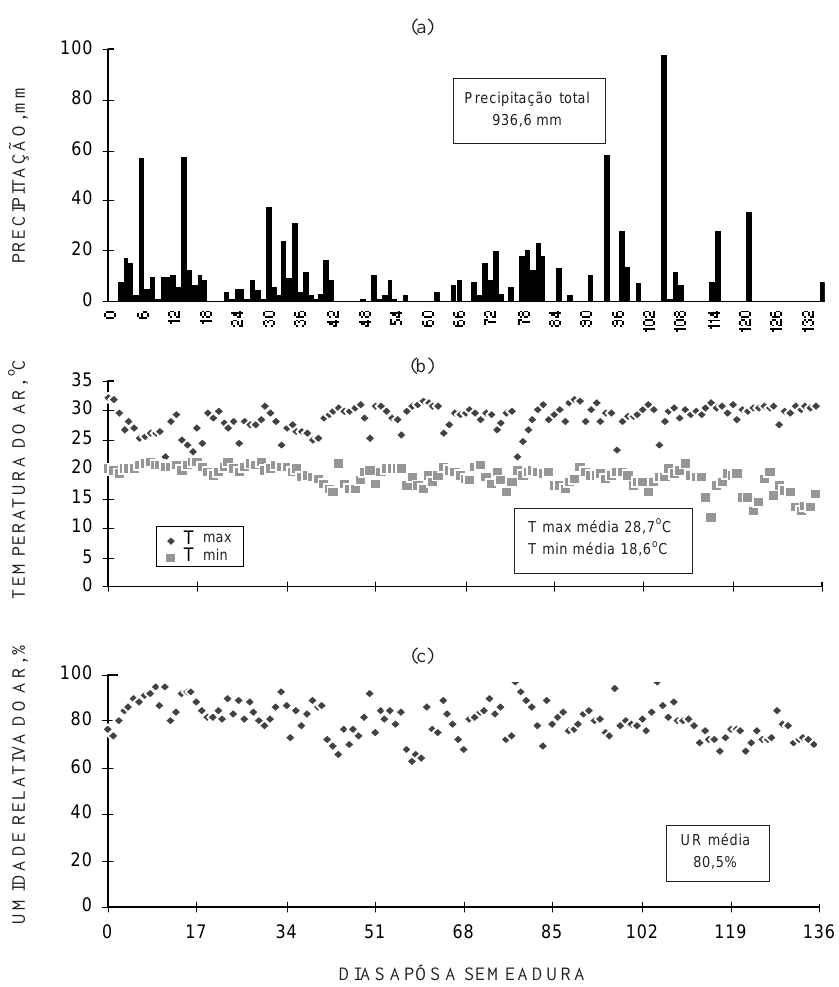
Figura 2. Elementos do clima durante a segunda época de semeadura (7 de janeiro de 1992): (a) precipitação (mm dia -1 ); (b) temperaturas máximas e mínimas do ar (ºC); (c) umidade relativa média do ar